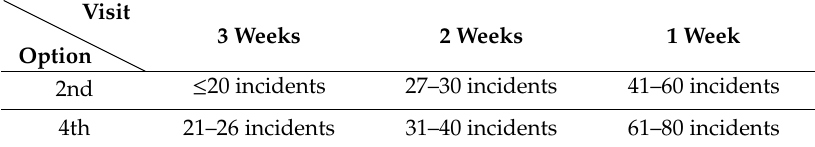
Table 4. Maintenance frequency based on monthly incidents and maintenance